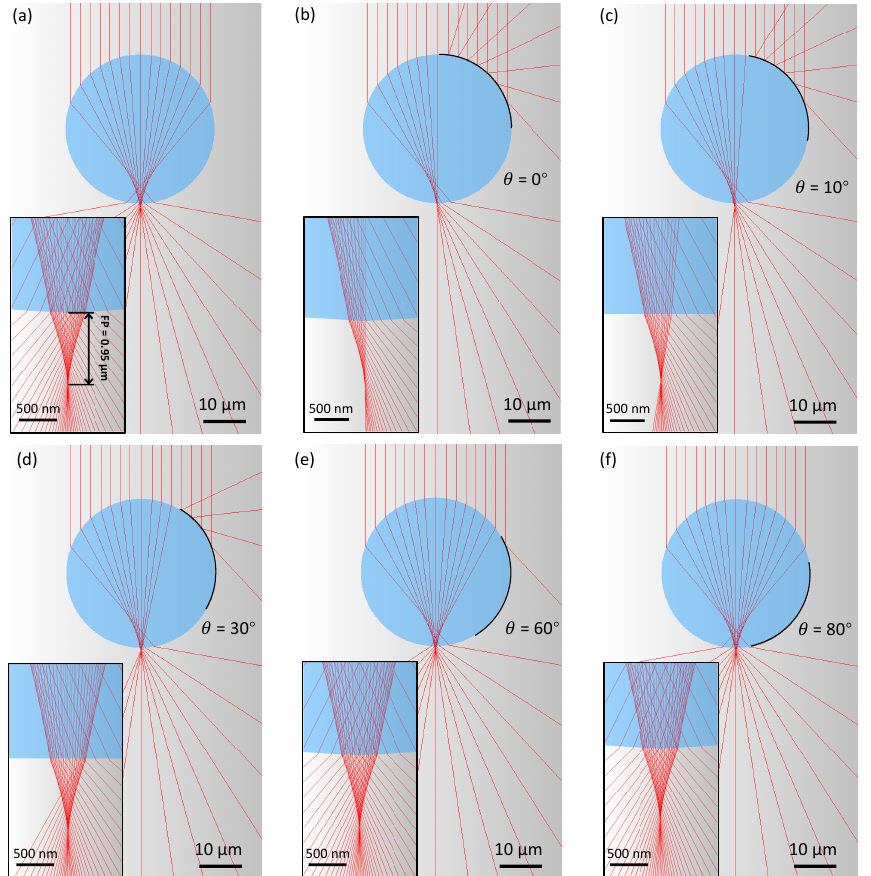
Figure 5. The focusing of pristine and patchy BTG particles in air simulated with the ray tracing method: ( a ) a pristine BTG; ( b – f ) p-BTG particles with Ag films at a rotation angle of ( b ) θ = 0 ◦ , ( c ) θ = 10 ◦ , ( d ) θ = 30 ◦ , ( e ) θ = 60 ◦ , and ( f ) θ = 80 ◦ . The inset figures show the corresponding focal